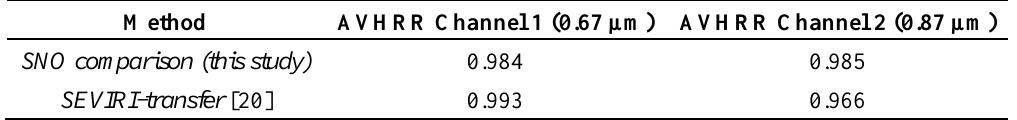
Table 11. Quota of normalized reflectance factors for AVHRR VIS and NIR channels for NOAA-18 in the period 2007–2009 deduced from SNO inter-comparisons (this study) and Spinning Enhanced Visible and Infrared Imager (SEVIRI)-transfer inter-comparisons